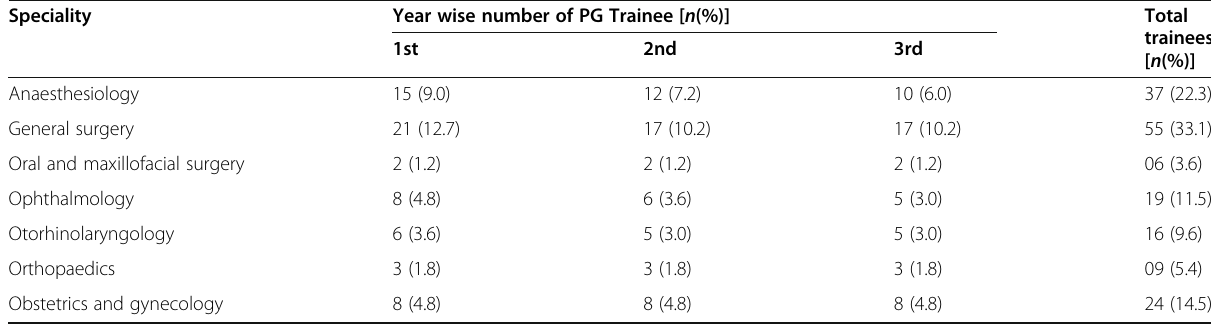
Table 2 Summary of year wise and subject wise distribution of postgraduate trainee respondents Speciality